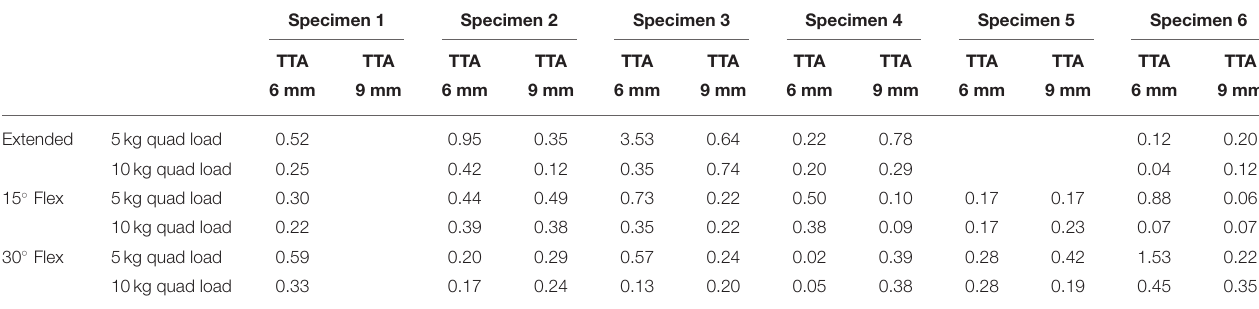
TABLE 3 | Translation of the tibia subsequent to performing the TTA relative to the translation of the tibia with the ligament cut at the loads listed in Table 1